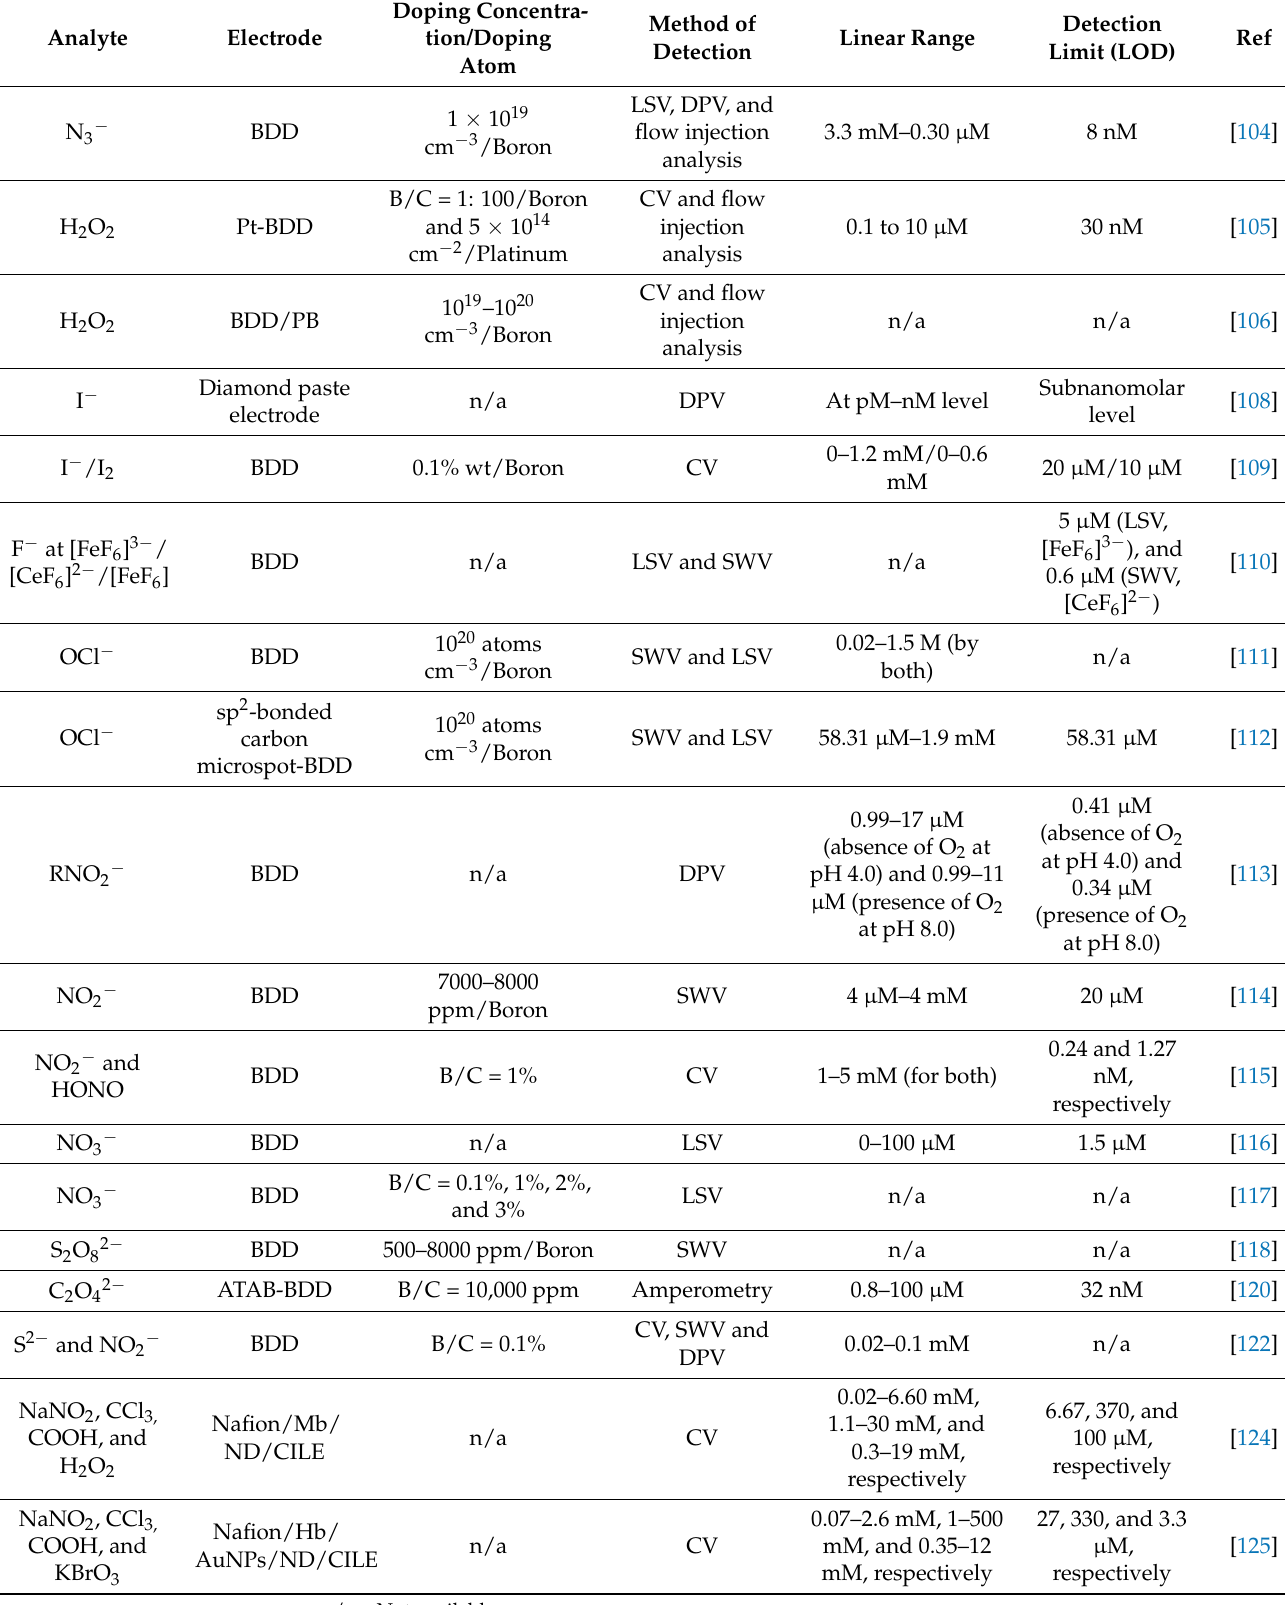
Table 2. Summary of diamond-based electrodes in the detection of